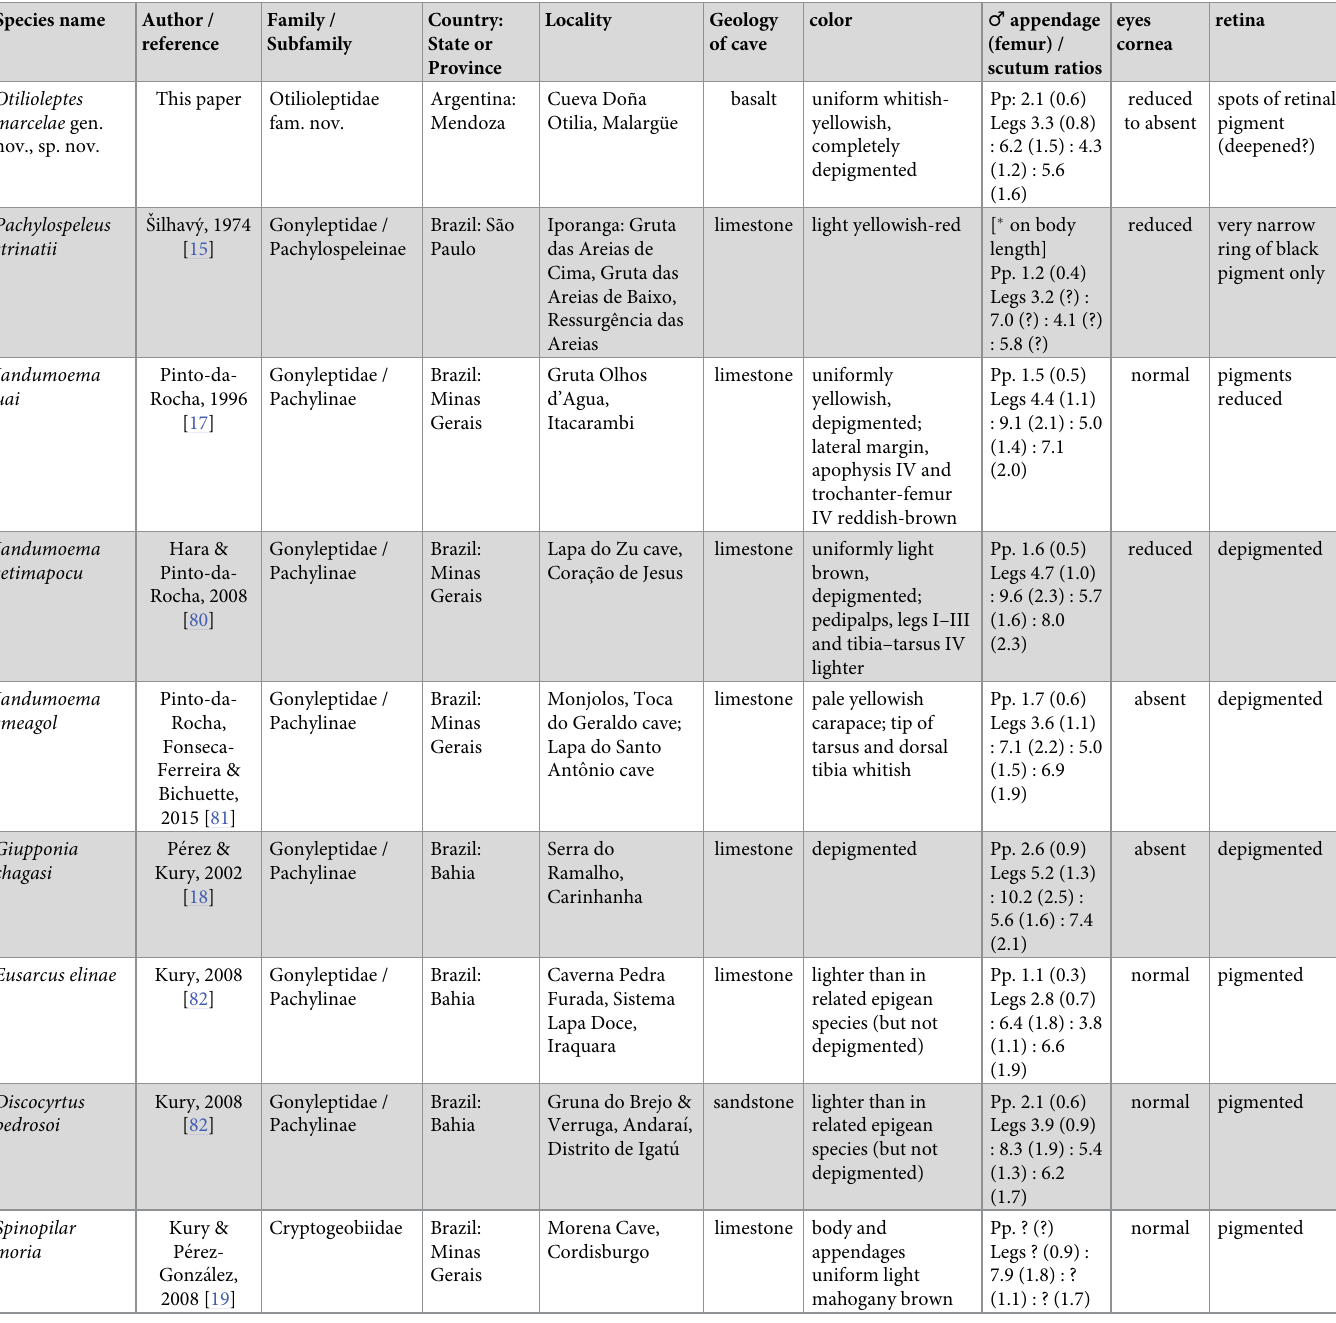
Table 5. An account of the known troglobitic South American gonyleptoids (Opiliones, Laniatores) and their troglomorphic traits. Ratios of appendage length (femur length, in parentheses) over scutum length (or over total body length � ) are based on measurements given in the literature, normally referred to the holotype; unavailable data indicated as